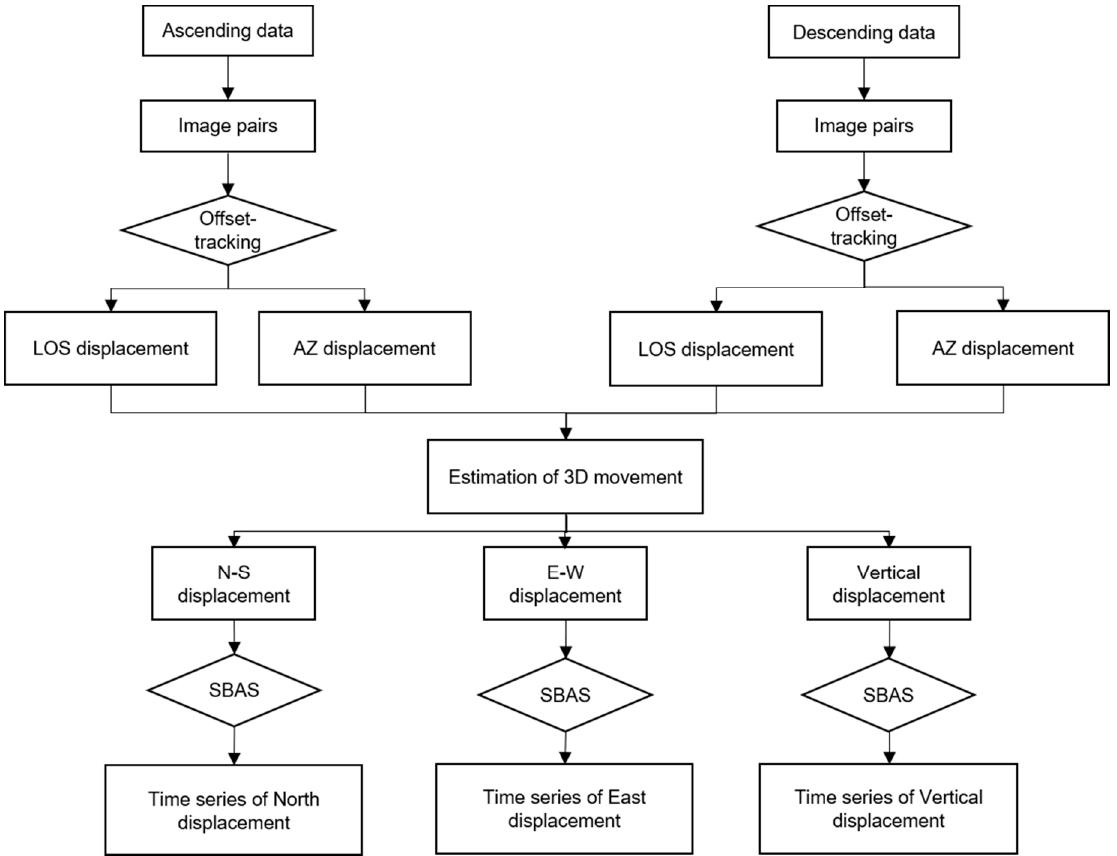
Figure 3. Flowchart of 3D time series displacement estimation.